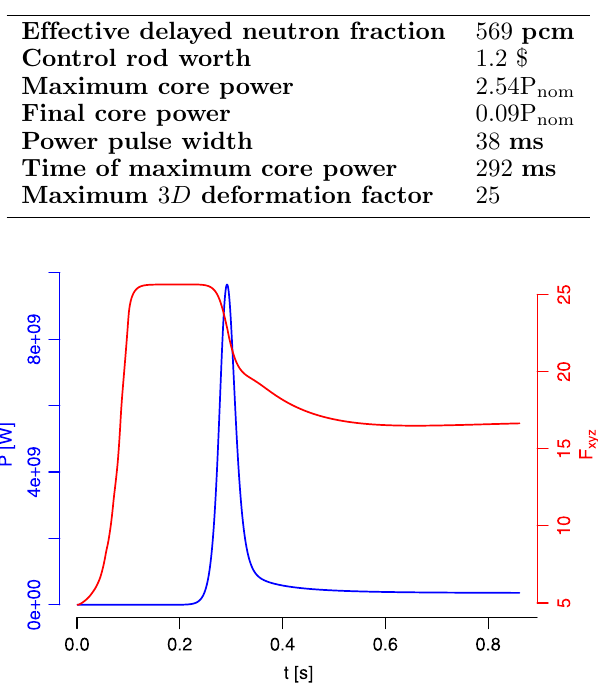
Table 2. Reference REA characteristic quantities.